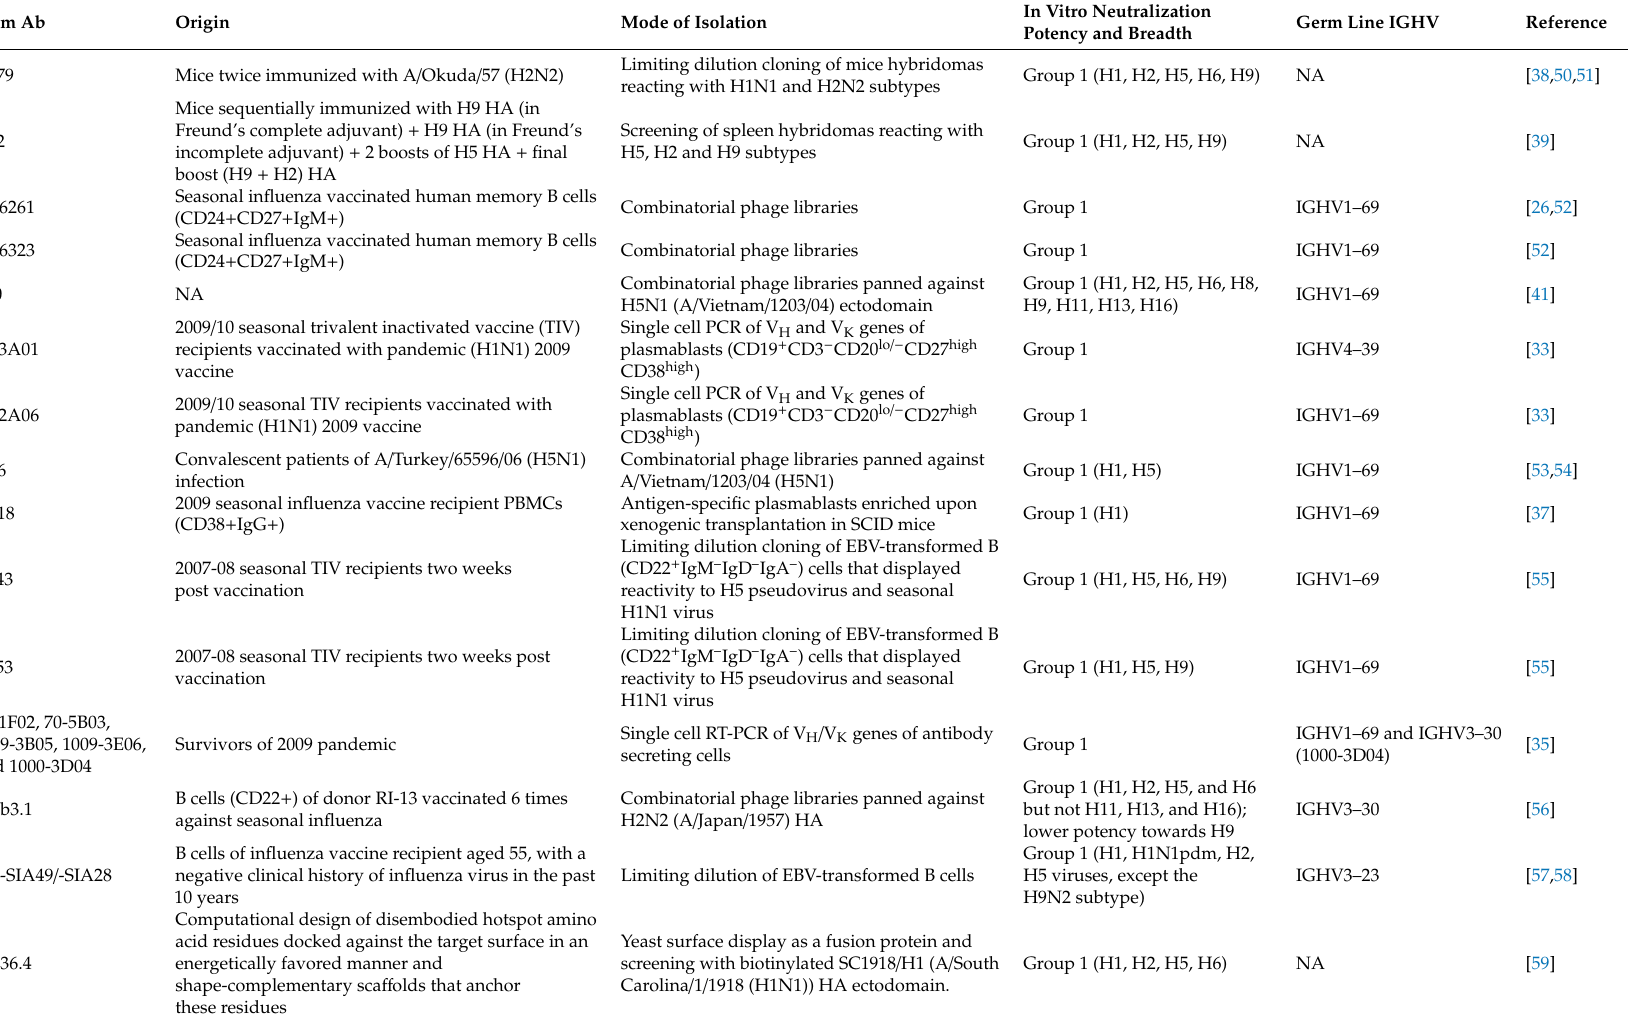
Table 1. List of stem-directed broadly neutralizing antibodies (sbnAbs) and their